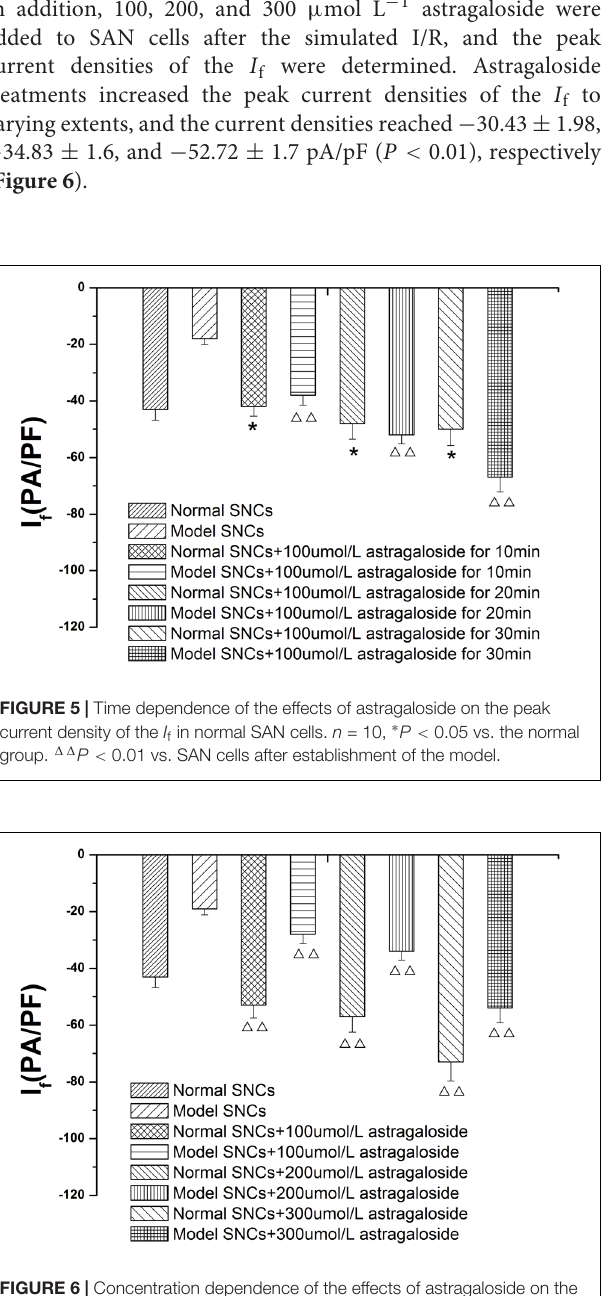
FIGURE 6 | Concentration dependence of the effects of astragaloside on the peak current density of the I f in normal SAN cells and damaged SAN cells. n = 10, (cid:49)(cid:49) P < 0.01, vs. SAN cells after establishment of the